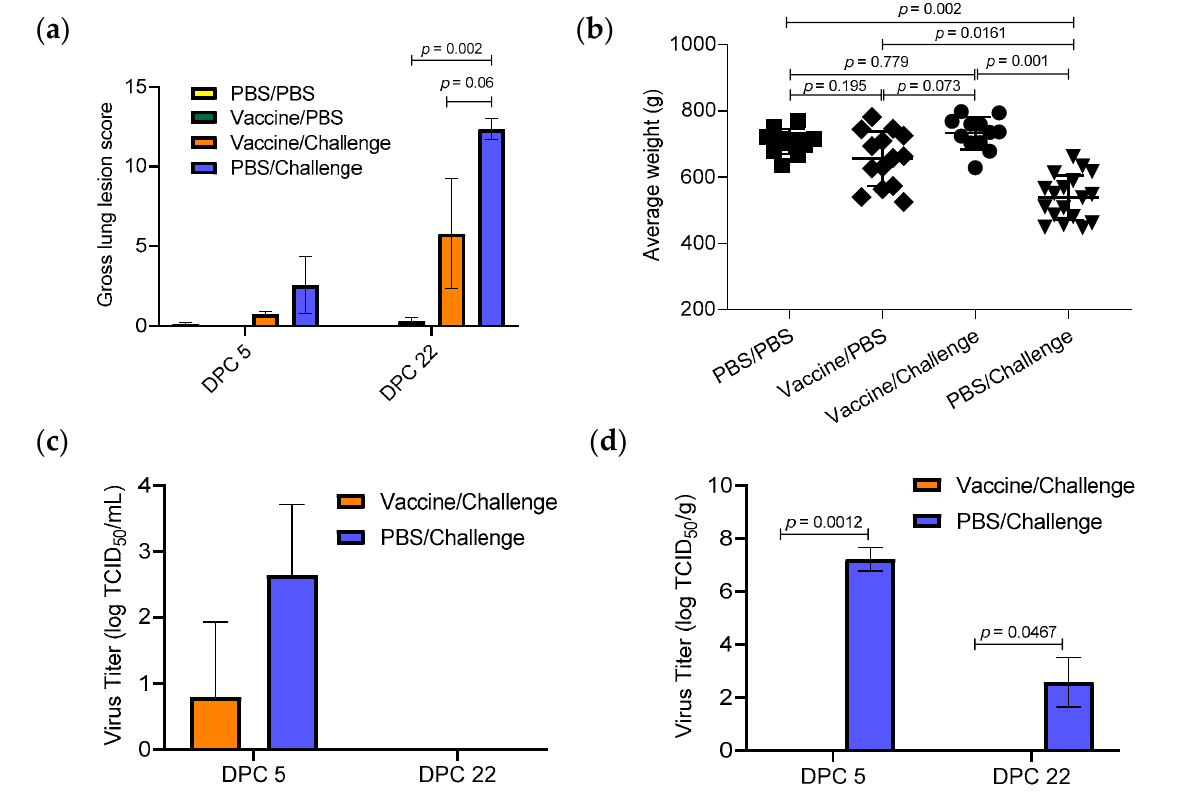
Figure 1. Clinical observations and viral titers after challenge. ( a ). Gross lung lesions of the sows at 5 DPC and 22 DPC. ( b ). Body weight of each fetus from different groups of sows. ( c , d ). Viral titers in nasal swabs ( c ) and lungs ( d ) from vaccine/challenge and PBS/challenge groups of sows at 5 DPC and 22 DPC. Statistical significance was determined by one-way ANOVA (Tukey’s test) and p value was indicated.